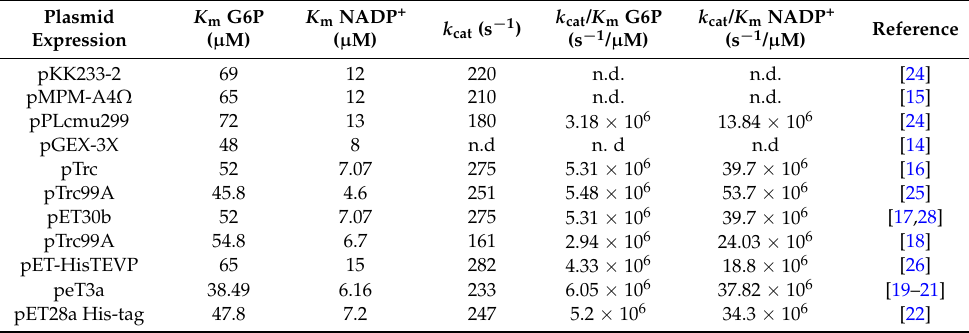
Table 2. Kinetic constants for recombinant human wild-type (WT) G6PDs and values of reported kinetic properties for human recombinant G6PD using different expression vectors. Plasmid